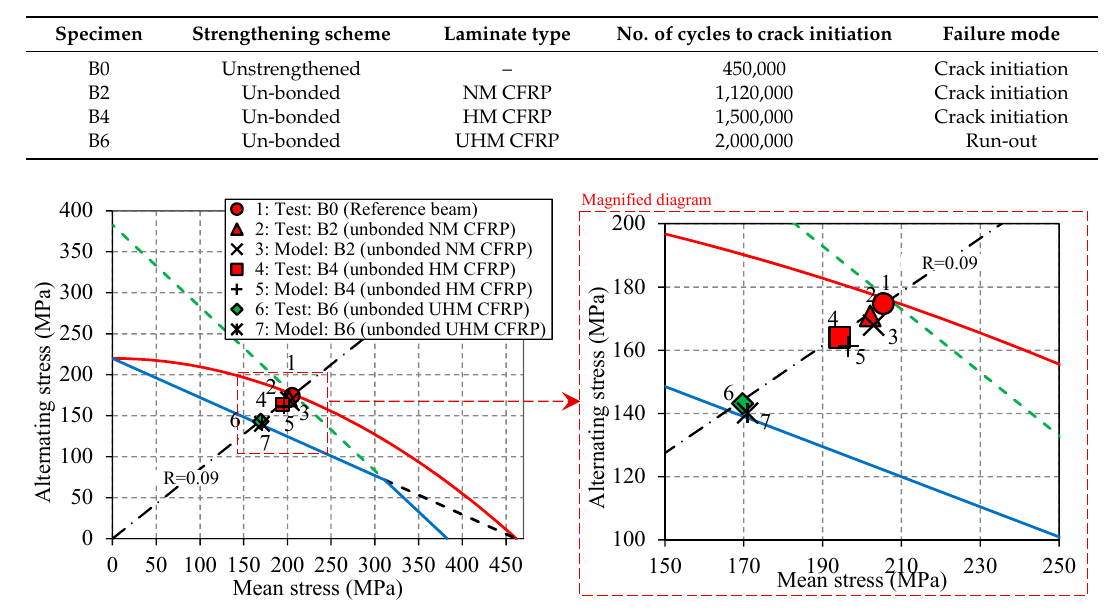
Figure 14. The CLD illustration of the experimental and modeling results. As the Young’s modulus of the CFRP plate increases, the stresses approach the safe zone along the original stress-ratio line.